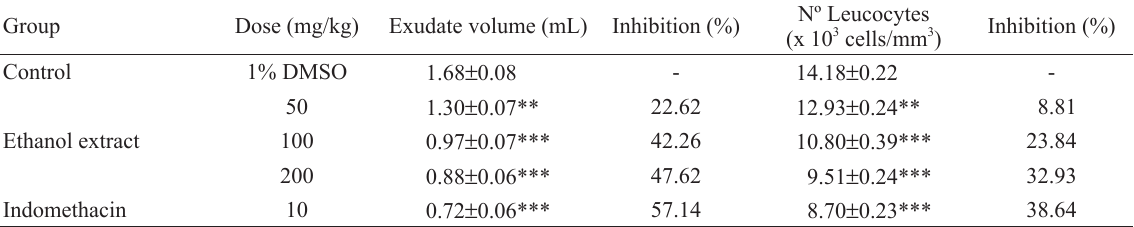
Effects of the ethanol extract from A. fastigiatum branches on pleural exudation and number of leucocytes in carrageenan-induced pleurisy in rats.